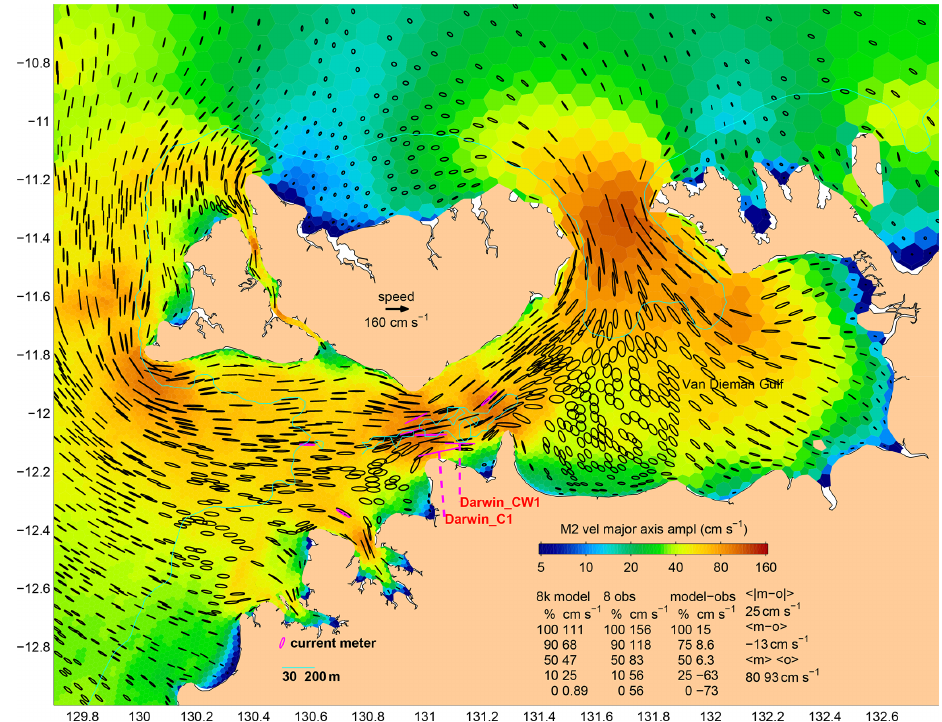
Figure 9. Amplitude of the M2 major axis velocity for the Darwin region; otherwise like Fig. 5.